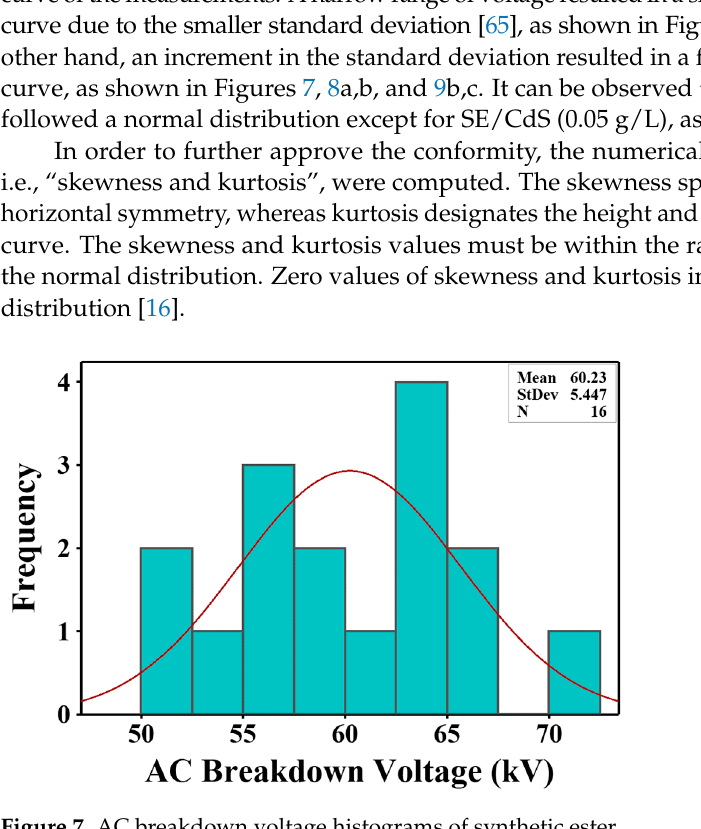
Figure 7. AC breakdown voltage histograms of synthetic ester.